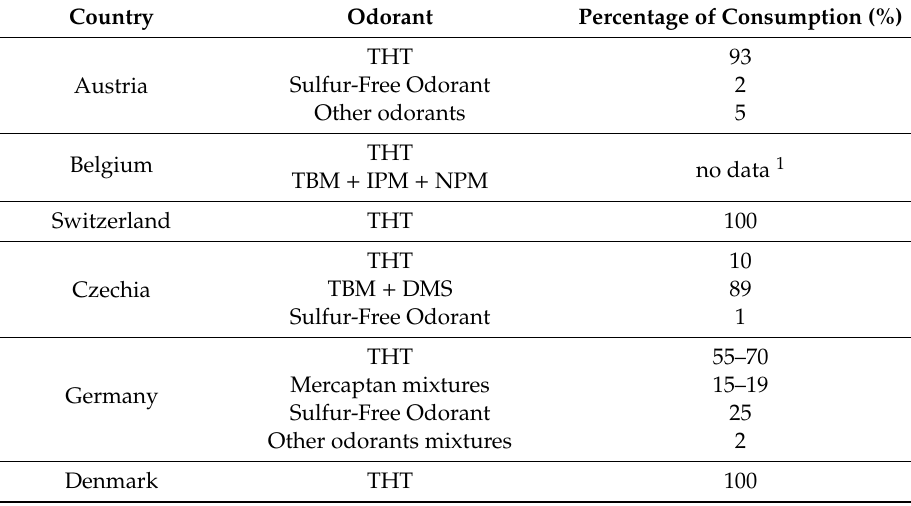
Table 1. Odorants in European gas odorization systems